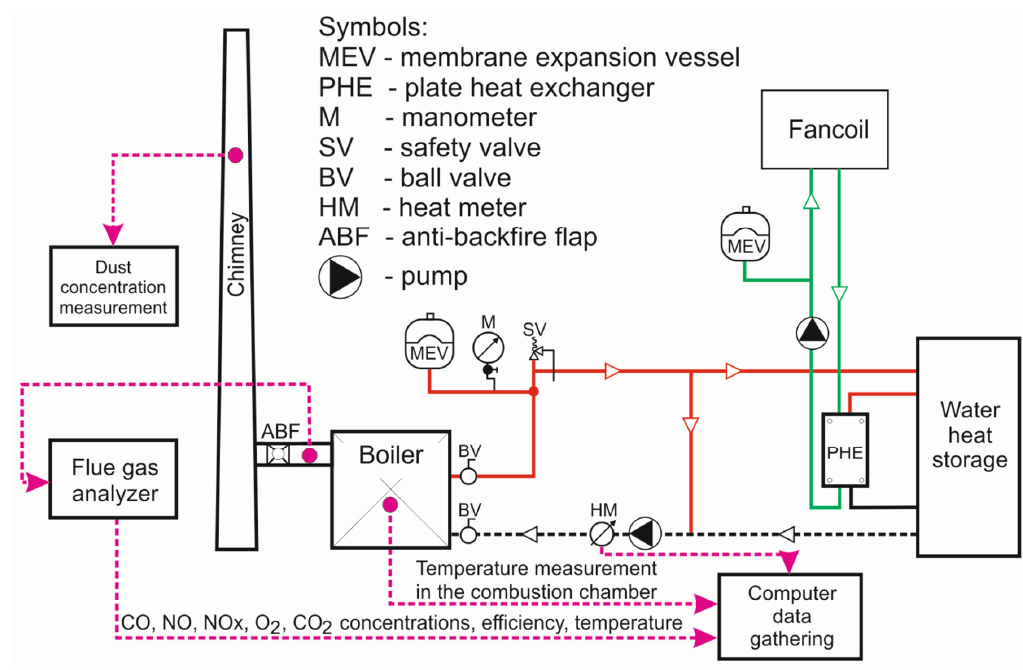
Figure 4. Boiler installation with measurement equipment.